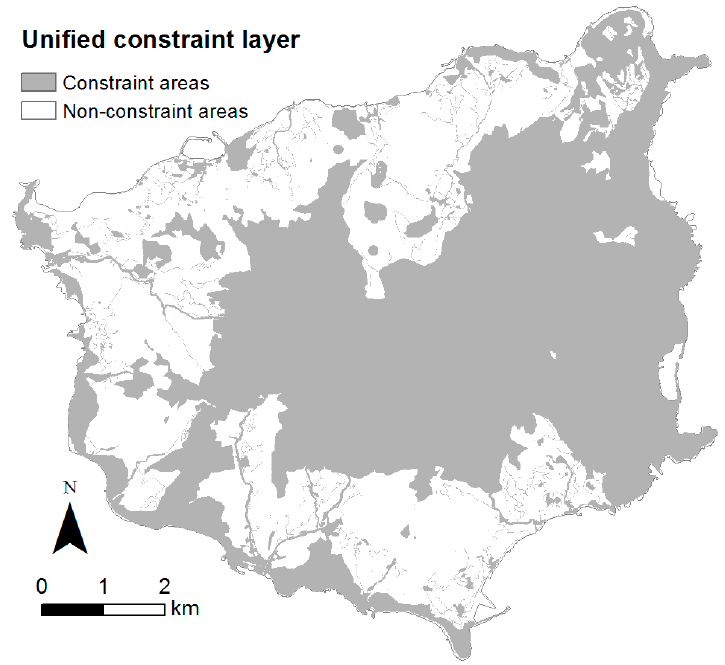
Figure A2. Unified binary constraint layer showing areas forbidden to PV farm